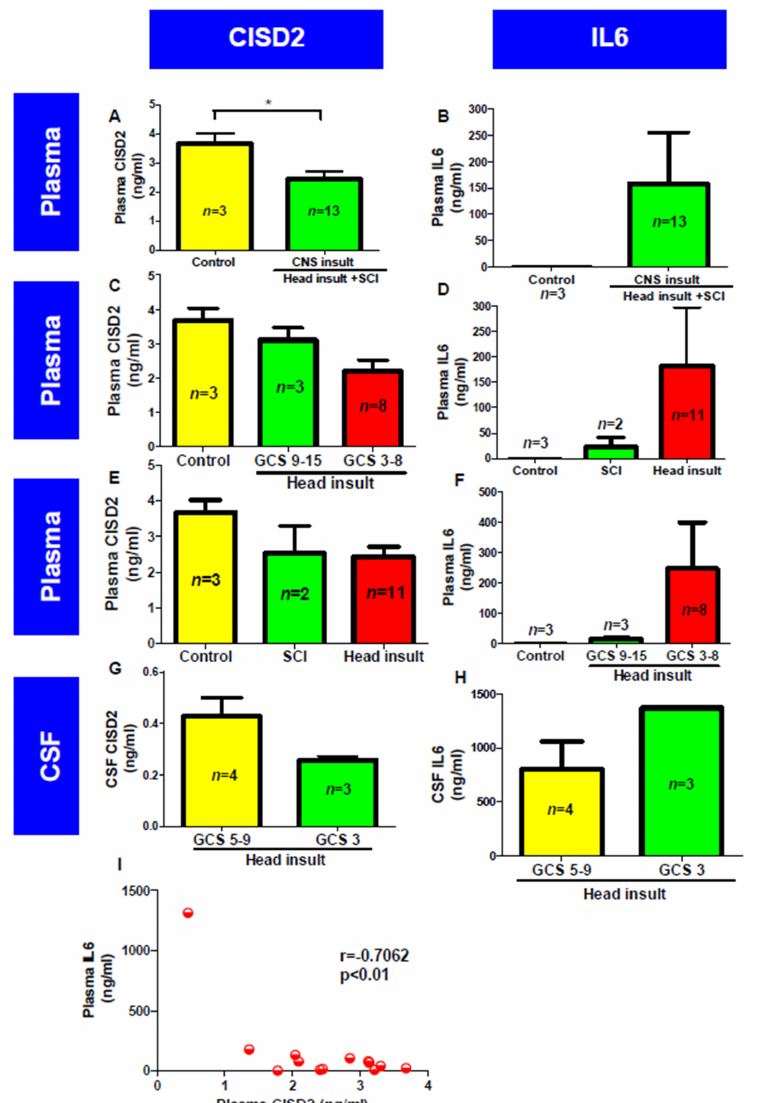
Figure 1. Clinical investigation of the enrolled patients with central nervous system (CNS) insults ( n = 13). ( A ) The plasma CISD2 levels in patients with CNS insult ( n = 13) were significantly lower than those in the healthy controls ( n = 3). Vertical bars indicate mean ± standard error of mean of enzyme-linked immunosorbent assay (ELISA) results. * p < 0.05 vs. healthy control group. ( B ) The plasma IL6 levels in 13 patients with CNS insults were higher than those in healthy controls. ( C ) The plasma CISD2 levels in patients with spinal cord injury (SCI) ( n = 2) or head trauma ( n = 11) were lower than those in healthy controls. ( D ) The plasma IL6 levels in patients with SCI and head trauma were higher than those in healthy controls. ( E ) The plasma CISD2 levels in the severe group (Glasgow Coma Scale (GCS) scores of 3–8) were lower than those in the mild group (GCS scores of 9–15). However, the plasma CISD2 levels in the severe and mild groups were markedly lower than those in the healthy control group. ( F ) The plasma levels of IL6 were higher and the plasma CISD2 levels were lower in the severe and mild groups than in the healthy control group. ( G ) Among the seven patients with head trauma, the CSF levels of CISD2 in the mild group (GCS scores of 5–9) ( n = 4) were higher than those in the severe group (GCS score of 3) ( n = 3). ( H ) The CSF levels of IL6 were lower and the CSF levels of CISD2 were higher in the mild group than in the severe group. ( I ) The correlation between plasma levels of CISD2 and IL6 in 13 patients with CNS insult was analyzed using linear regression. The plasma levels of CISD2 were negatively correlated with those of IL6 (r = − 0.7062; p < 0.01). These findings indicated that CISD2 is a biomarker for CNS